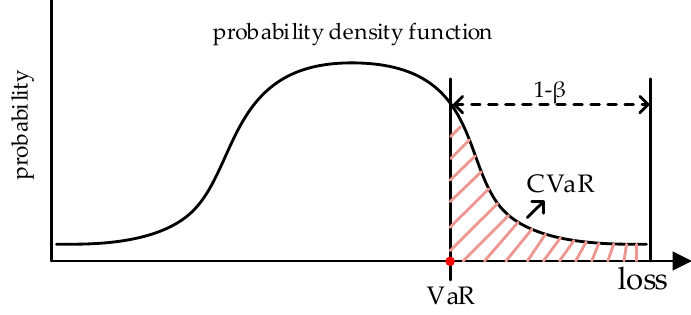
Figure 3. Framework of the conditional risk value (CVaR).